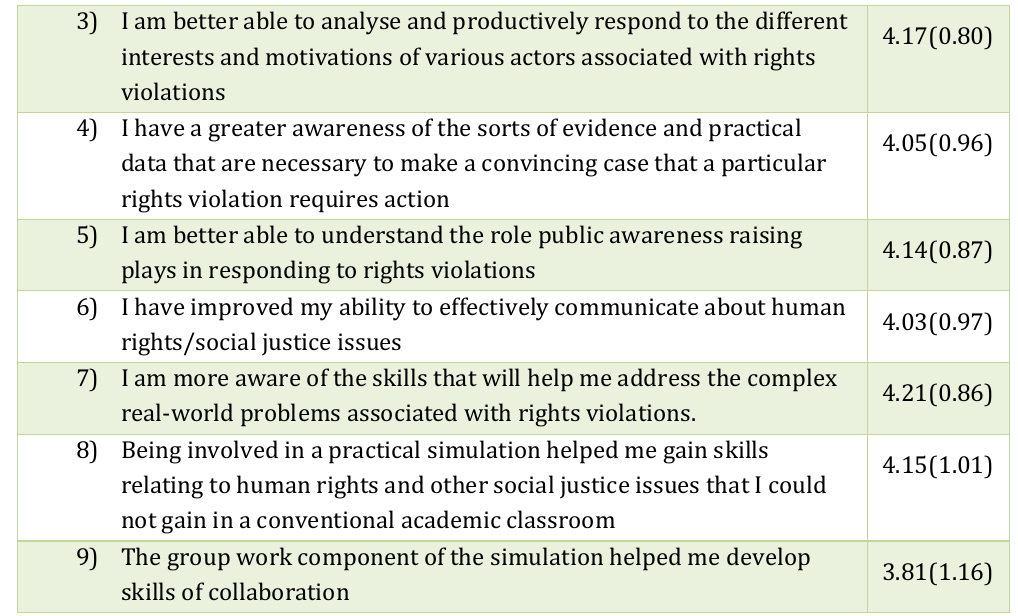
Table 2. Mean (M) and Standard Deviation (SD) for all the quantitative items. Notes: All scales ranged from